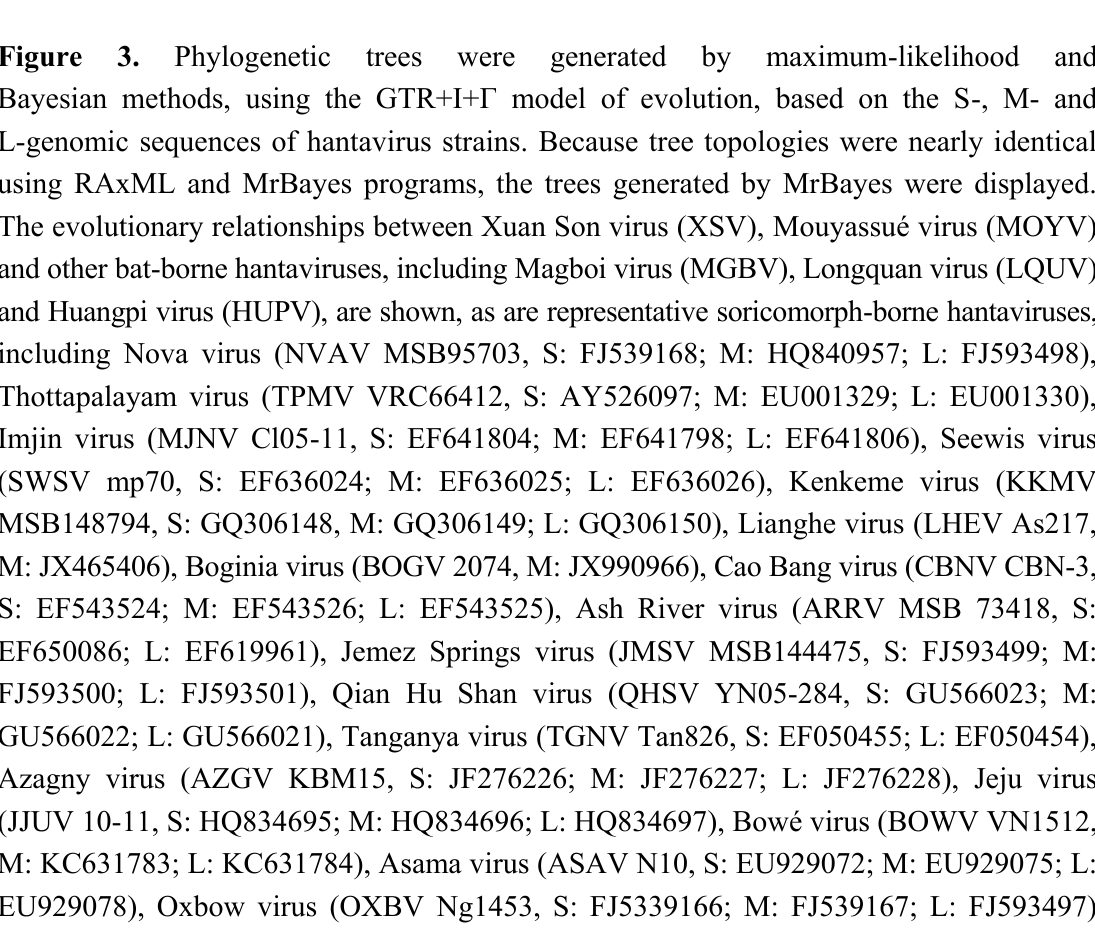
Figure 3. Phylogenetic trees were generated by maximum-likelihood and Bayesian methods, using the GTR+I+Γ model of evolution, based on the S-, M-